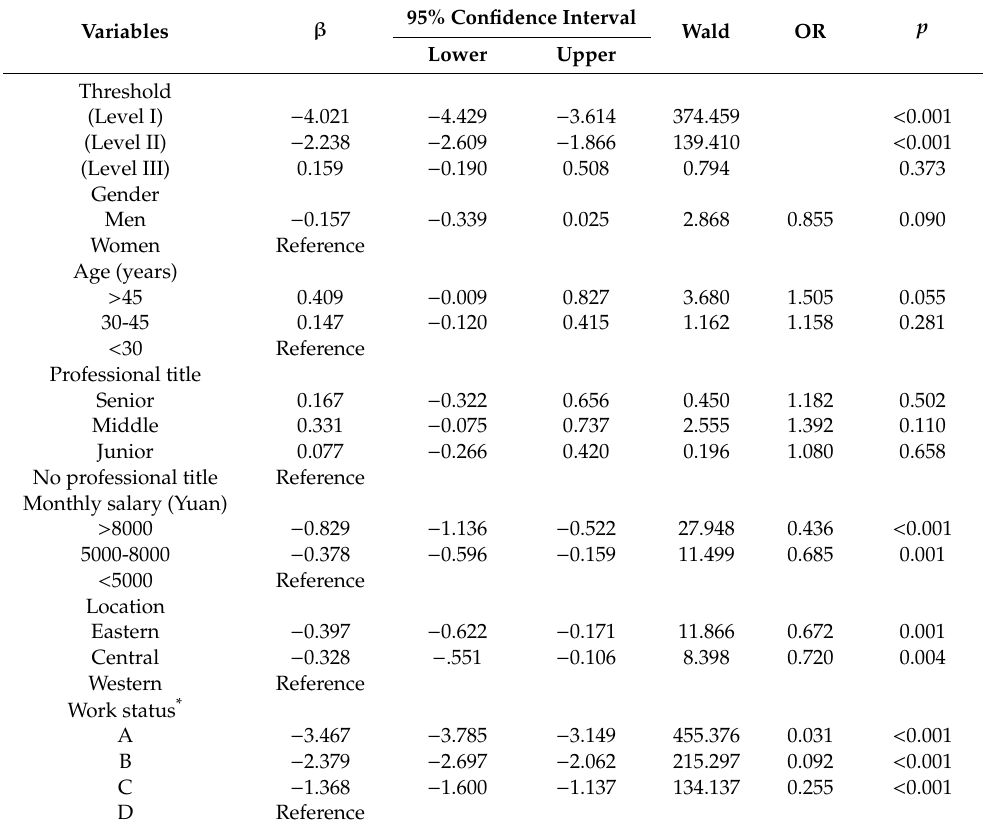
Table A1. Ordinal logistic regression modelling on accumulated fatigue with summarized work